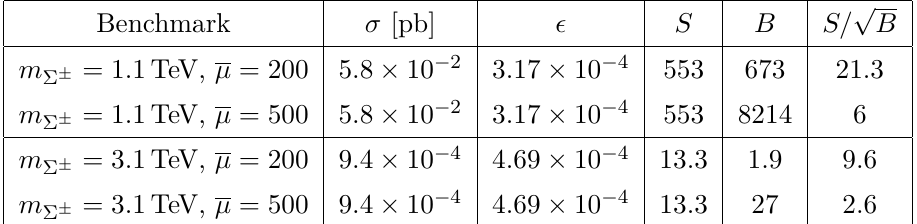
, cτ ) = ( 3 . 1 TeV, 59 . 96 mm), wherein the table ¯ µ Σ ± Σ ±